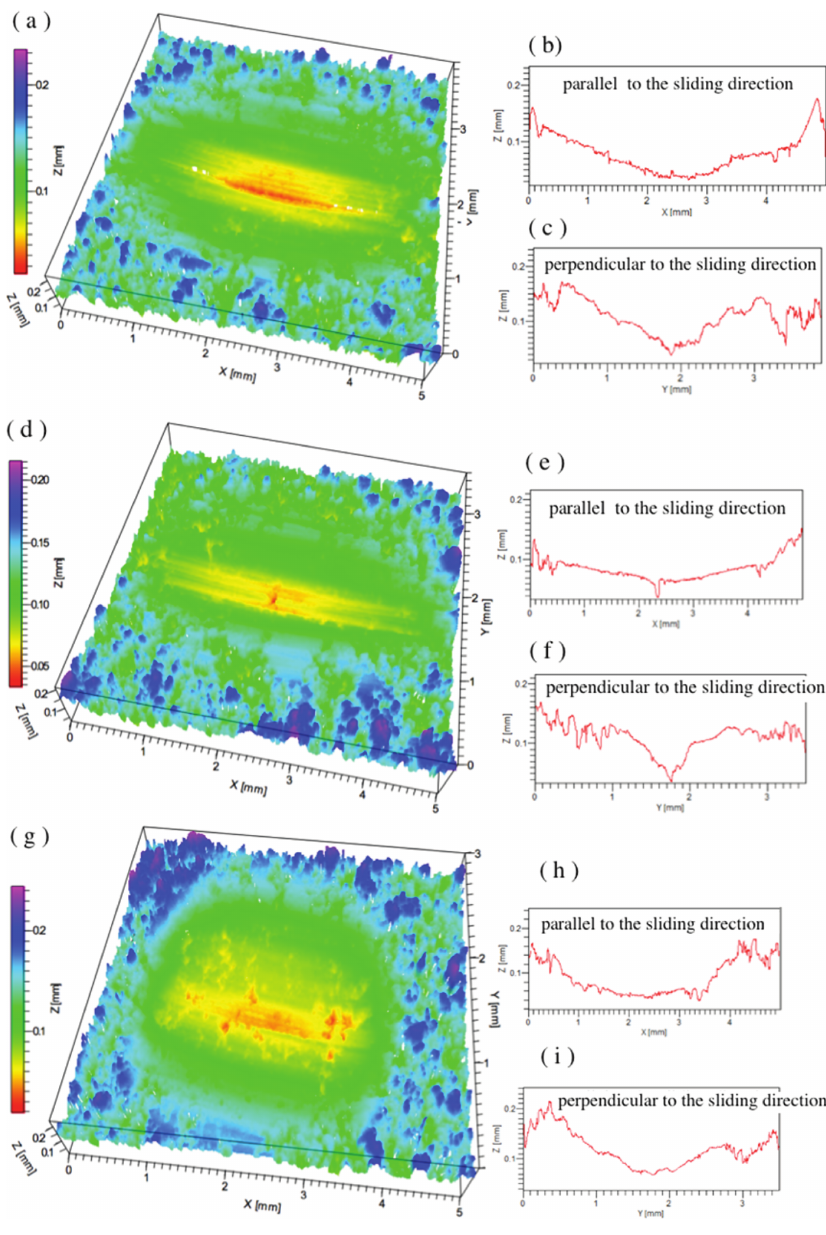
Table 3: Wear depths of the specimens bearing different loads.